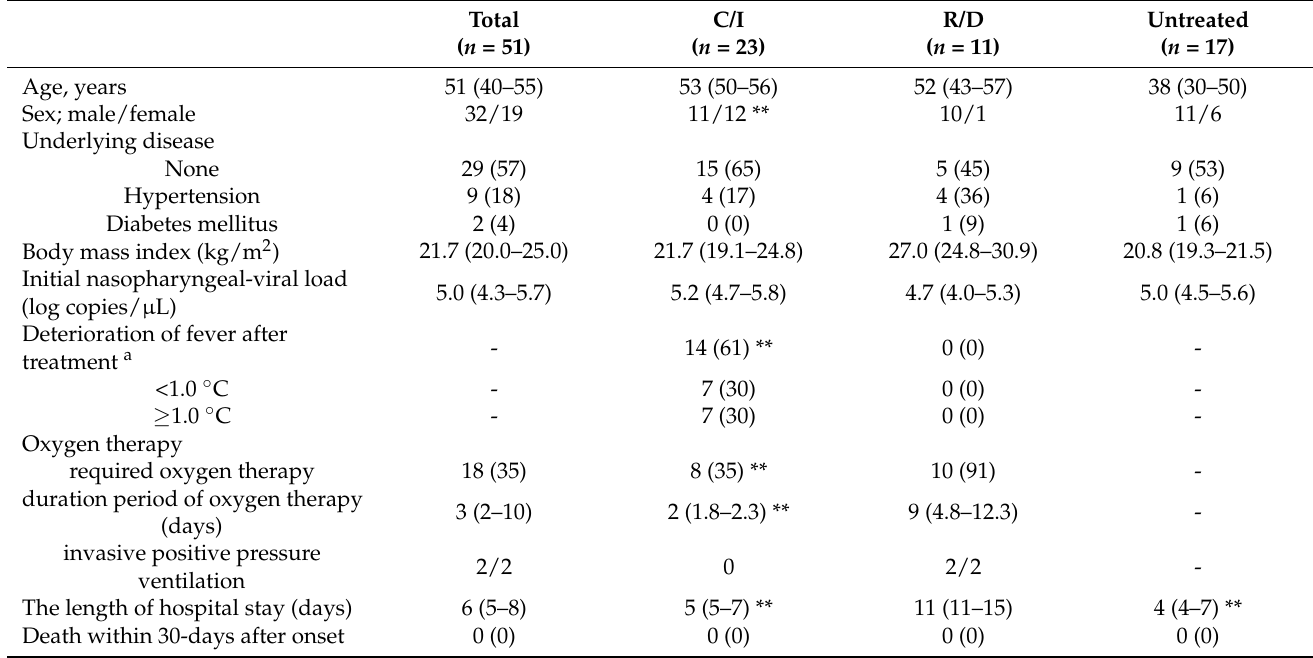
Table 1. Clinical feature of patients with SARS-CoV-2 infection in the early